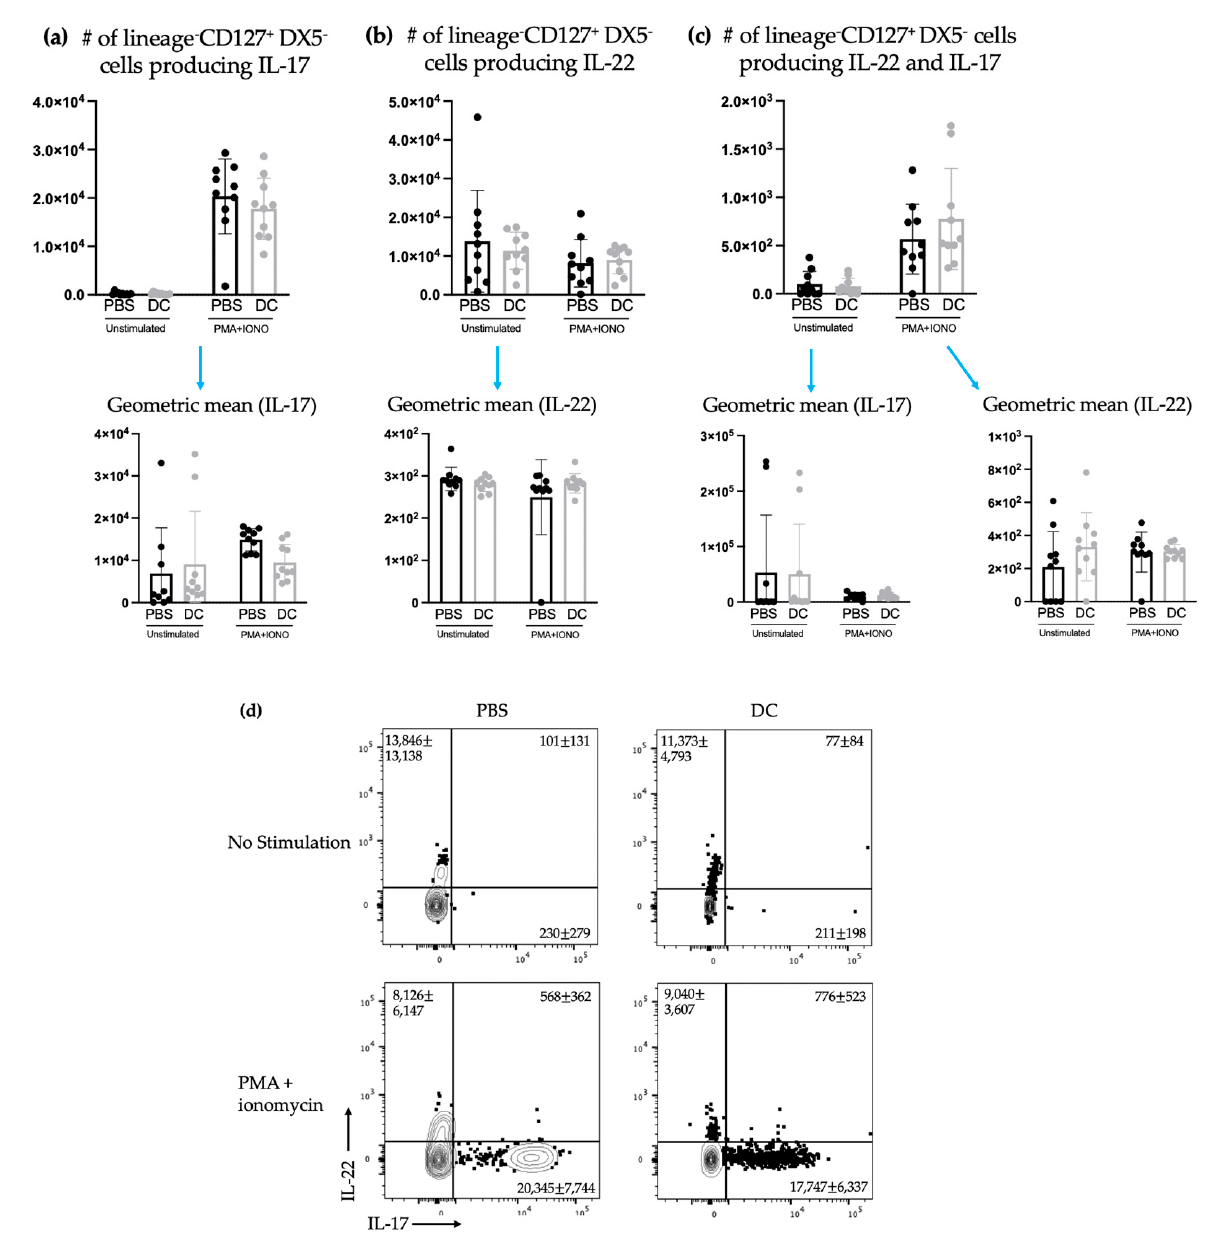
Figure 5. There was no change in the number of splenic IL-17 and/or IL-22-producing ILCs after DC vaccination and challenge with B16F10 melanoma cells. Female C57BL/6 mice ( n = 10) were inoculated with DC vaccines via hind footpad injection and one week later, 3 × 10 5 B16F10 cells were administered intravenously. Three days later, spleens were harvested and examined for ILC3 cytokine productions. The number of lineage − CD127 + DX5 − cells producing ( a ) IL-17, ( b ) IL-22, and ( c ) both IL-17 and IL-22 and their corresponding geometric mean fluorescent intensities was determined using intracellular cytokine staining and flow cytometry. Data were analyzed using a two-way ANOVA test and no significant difference between the DC-vaccinated mice and the phosphate-buffered saline (PBS)-treated controls was detected. ( d ) Representative dot plots show the average number of splenic CD45 + lineage − CD127 + DX5 − cells producing IL-17 and/or IL-22. The bar graphs and error bars display the mean and standard deviation. Intravenous injection of B16F10 cells via the tail vein is a common mouse model of synthetic melanoma metastases to the lungs [30]. Therefore, the lungs were also examined to determine the number of ILC3 subpopulations and assess their production of